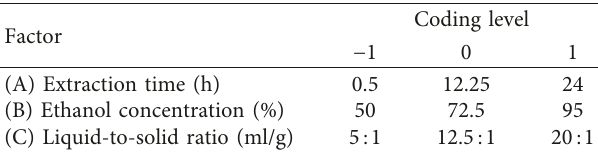
Table 1: Box–Behnken design of various factors and their coding levels.